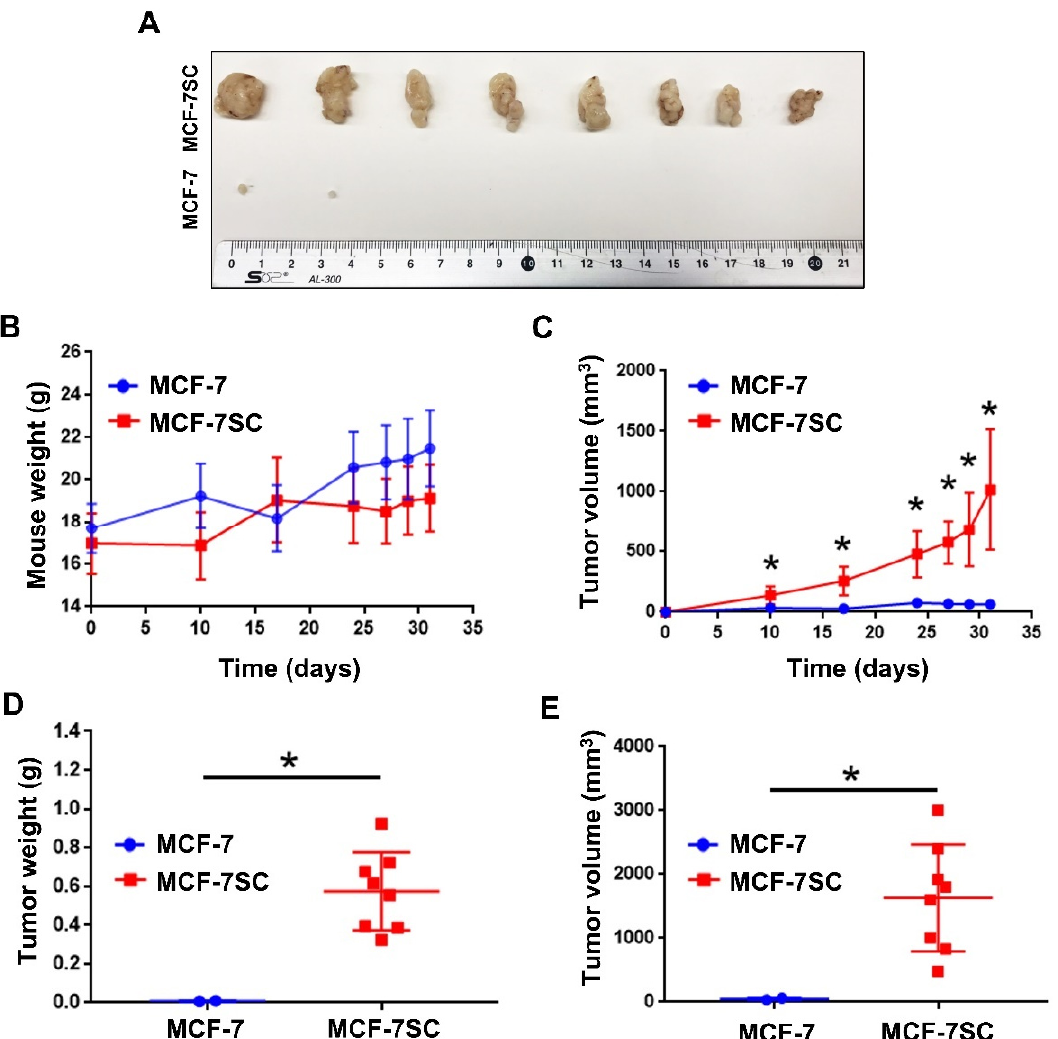
Figure 1. MCF-7SCs exerted higher tumorigenic capacity. ( A ) Representative tumors isolated from BALB/C nude mice injected with MCF-7 cells and MCF-7SCs (5 × 10 6 cells per tumor). ( B ) Weight of BALB/C nude mice after injection of MCF-7 cells and MCF-7SCs at days 10, 17, 24, 27, 29, and 31. ( C ) Tumor volume at days 10, 17, 24, 27, 29, and 31. ( D ) Tumor weight and ( E ) tumor volume at day 31 after euthanizing the mice; * p < 0.05 vs. control; statistical values represent data from three biologically independent experiments.